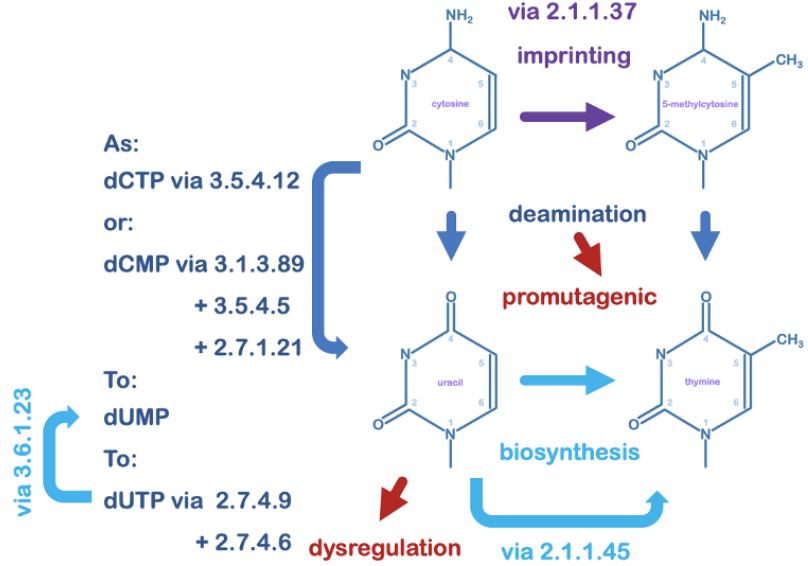
Figure 1. DNA pyrimidines and their interconversion. The pyrimidine uracil as a deoxynucleotide is